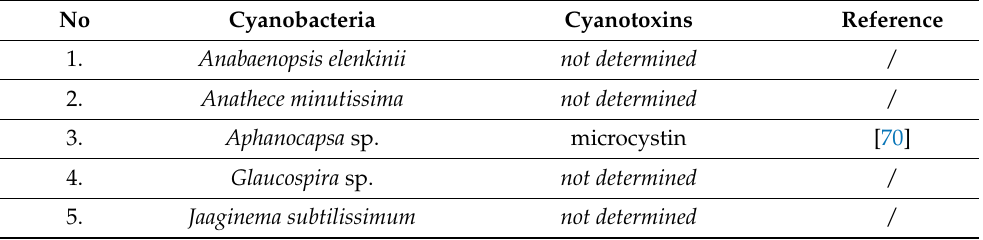
Table 4. Cyanobacteria detected in Aleksandrovac Lake in 2020 and 2021 and potential present cyanotoxins.